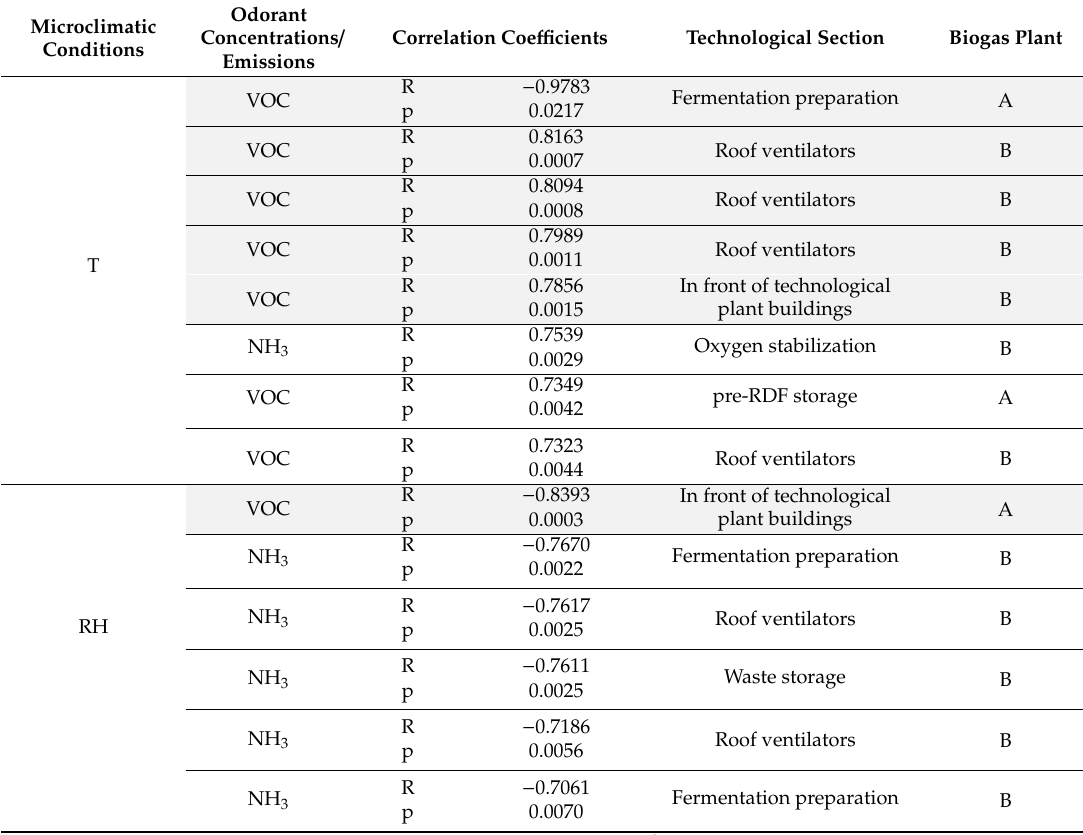
Grey colour—correlations with R 2 ≥